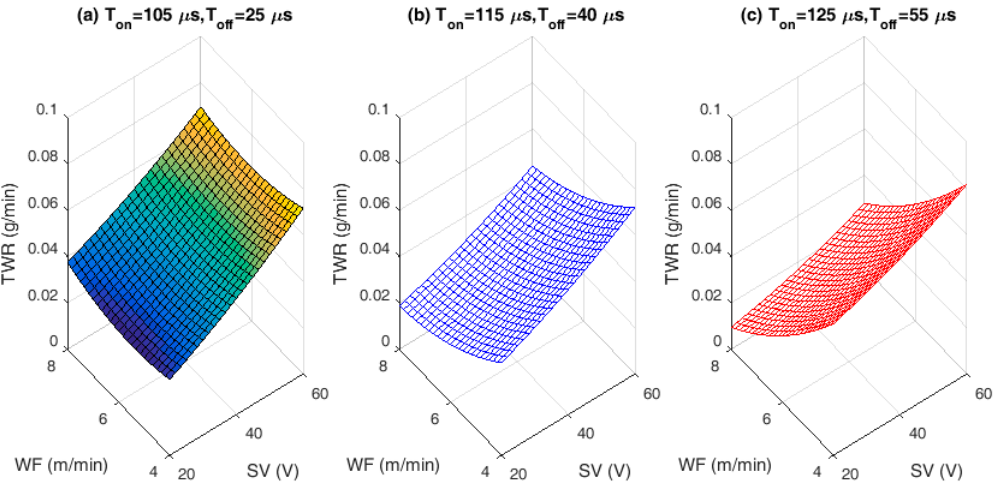
Figure 6. Interaction effects of input process variables on tool wear rate (TWR): ( a ) Lower hold values of T on and T off . ( b ) Middle hold values of T on and T off . ( c ) Higher hold values of T on and T off .